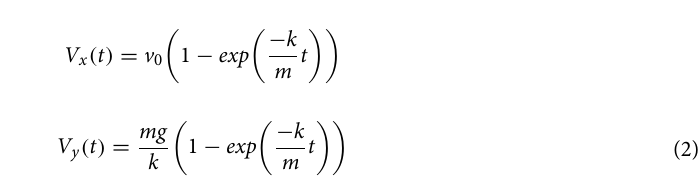
Figure 7. Relationship between dust speed of ( a ) flour particles and ( b ) calcium carbonate particles measured by LCDL and wind speed by the anemometer. A linear agreement is observed in the range of 0–5 m/s wind speed. The slope of calcium carbonate flow is lower than that of